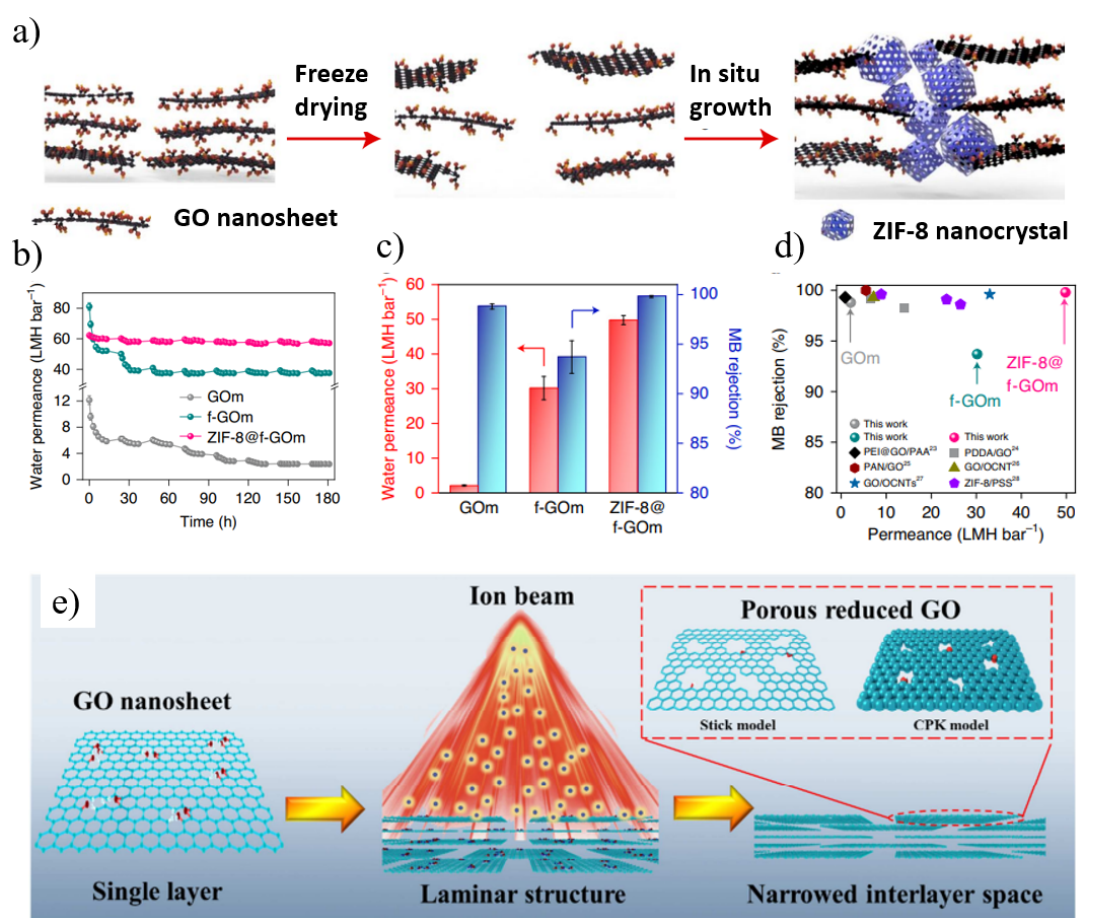
Figure 6. ( a ) Schematic of ZIF-8@f-GOm preparation. ( b ) Pure water permeance (in LMH bar –1 ) of GOm, f-GOm and ZIF-8@f-GOm over a 180 h operating period ( c ) Water permeance and MB rejection for GO-based membranes. ( d ) Comparison of MB rejection and water permeance for GO-based membranes reported in the literature with the GO-based membranes used in this work. ( e ) Schematic illustrations of ion beam engineering for GO membranes. Reprinted with permission from [90,91]. Copyright (2021) the author(s), under exclusive license to Springer Nature Limited. Copyright (2019) Published by Elsevier Ltd.